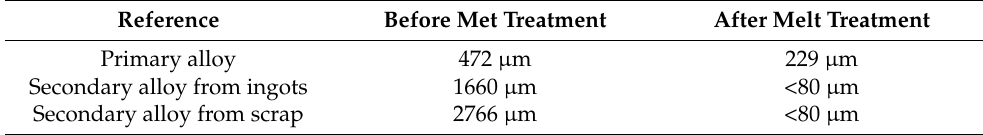
Table 5. Thicknesses of the inclusion cakes.